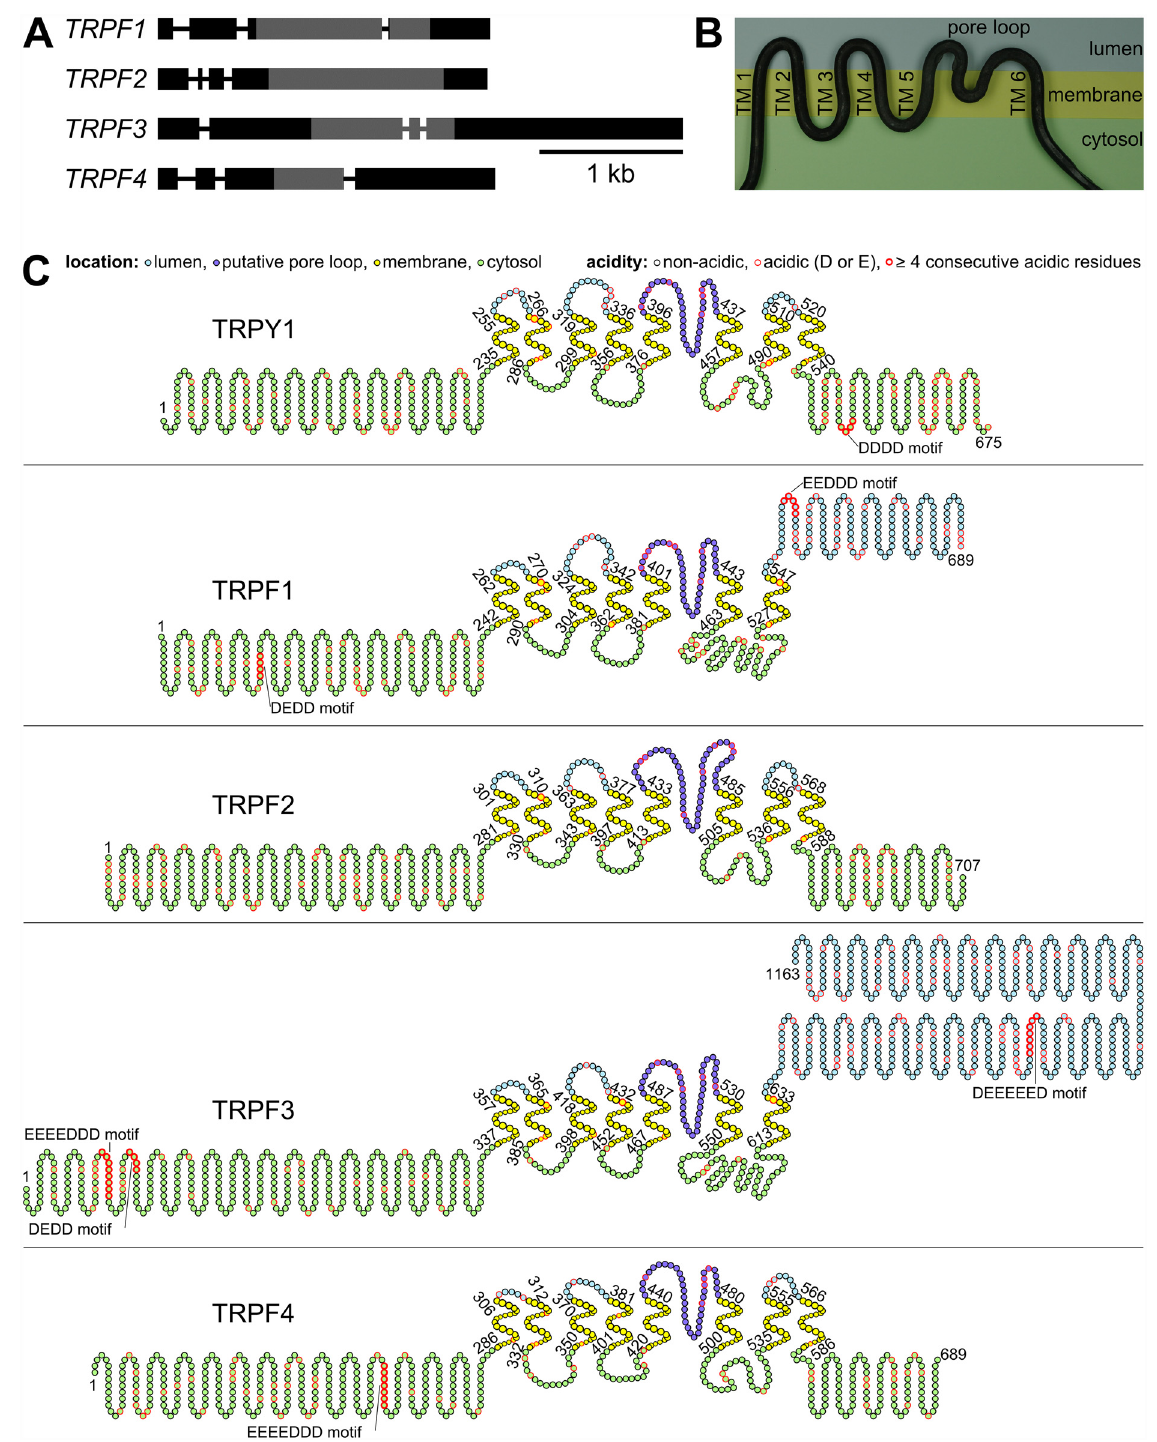
Fig 1. Gene structures of C . graminicola TRPF genes and predicted membrane topologies of yeast TRPY1 and C . graminicola TRPF proteins. (A) Gene structures of CgTRPF genes. Boxes: exons, lines: introns; grey: match of the initial tBLASTn search against TRPY1, black: regions identified by RACE-PCR and verified by cloning PCR. (B) Artistic representation (forged steel) of the TRP channel core structure containing six transmembrane (TM) domains and a pore loop between TM domain 5 and 6. (C) Predicted membrane topology of TRPY1 and CgTRPFs. Cytosolic amino acid residues are indicated in light green, TM domains are shown in yellow, luminal amino acid residues are depicted in light blue, and the predicted pore loop is marked in dark